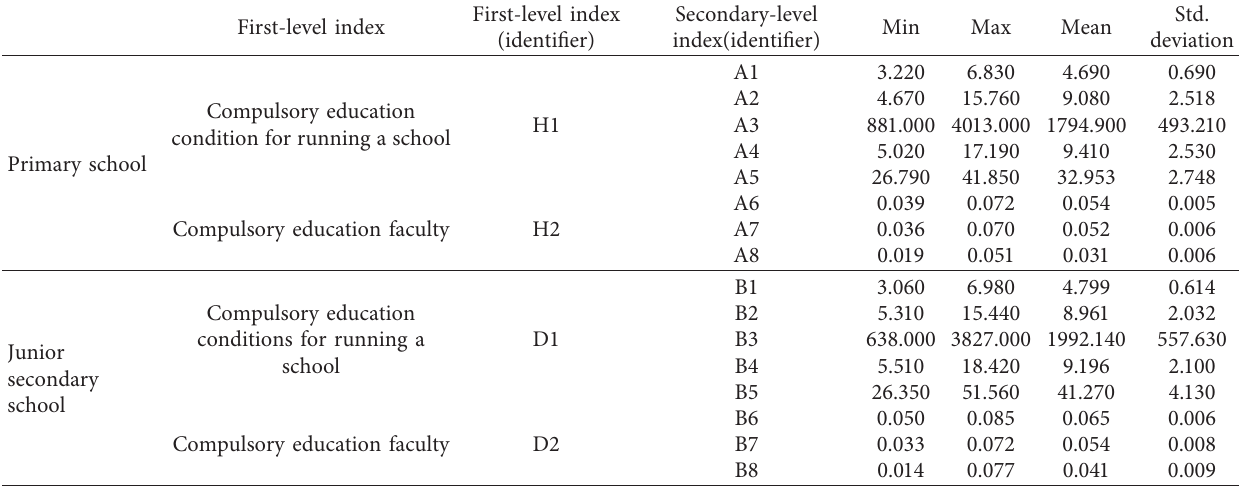
Table 1: Index of primary schools and junior secondary schools and descriptive